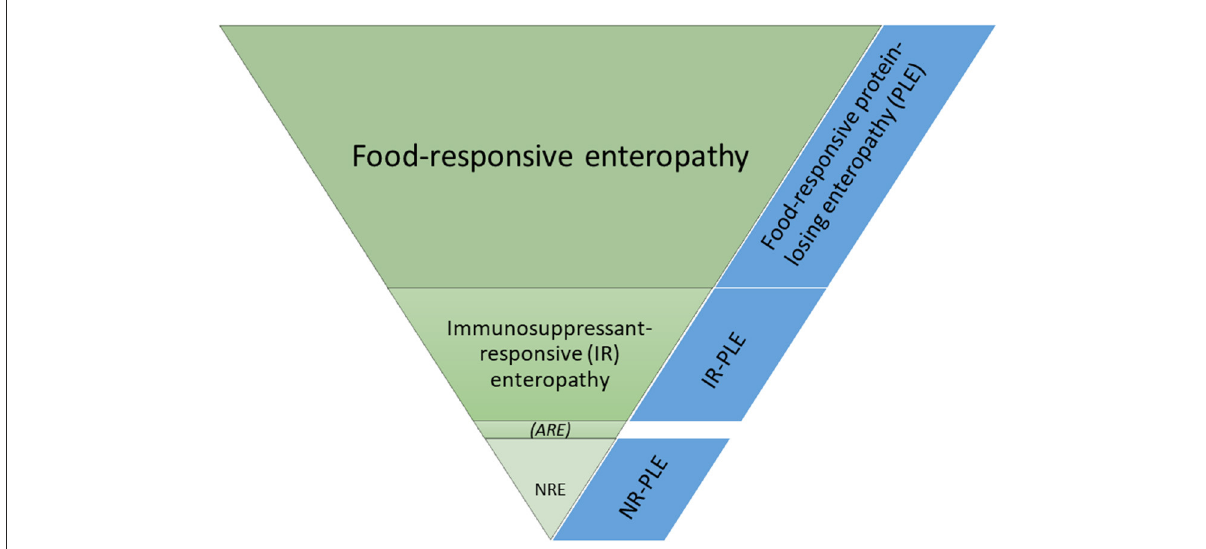
FIGURE2 Frequencies of the different subgroups of chronic inflammatory enteropathies in dogs. ARE, antibiotic-responsive enteropathy (idiopathic intestinal dysbiosis); NR, non-responsive; NRE, NR